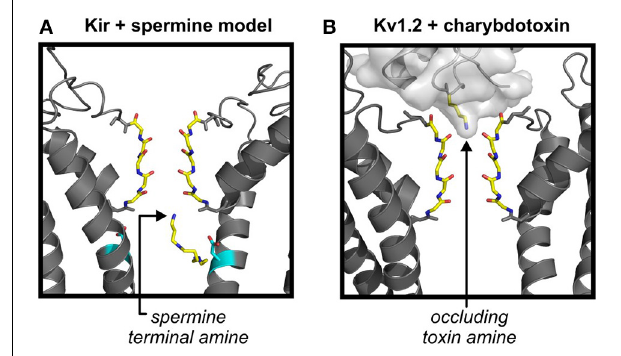
FIGURE 6 | Does charybdotoxin binding reveal details of amine interactions with the selectivity filter? (A) Depiction of a previously published molecular model of Kir2.1 with a polyamine bound in a deep site in the Kir inner cavity (Kurata et al., 2008). The trailing end of the polyamine is anchored around the “rectification controller” position, while the leading end engages with the most superficial intracellular aspect of the selectivity filter. Docking simulations were carried out using Autodock, and multiple molecular models of Kir2.1 (depicted) or Kir6.2[N160D], based on the KirBac1.1 crystal structure. (B) Recent crystal structure of charybdotoxin in complex with Kv1.2, illustrating an essential lysine interacting with the most superficial extracellular aspect of the selectivity filter. Both spermine and the occluding lysine side chain have similar functional groups (protonatable amines) at their termini, and both blocker types are particularly sensitive to ion concentrations on the “trans” side.